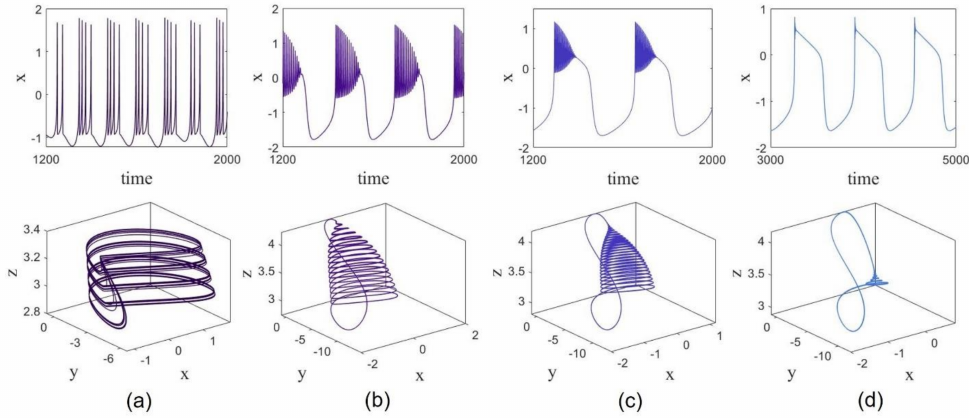
Figure 2. Dynamics of the Hindmarsh-;Rose neuron model states with different fractional-order derivatives. The first row shows the time series of the membrane potential, and the second row shows its corresponding attractor in the ( x , y , z ) space: ( a ) q = 1, ( b ) q = 0.9; ( c ) q = 0.8; ( d ) q =